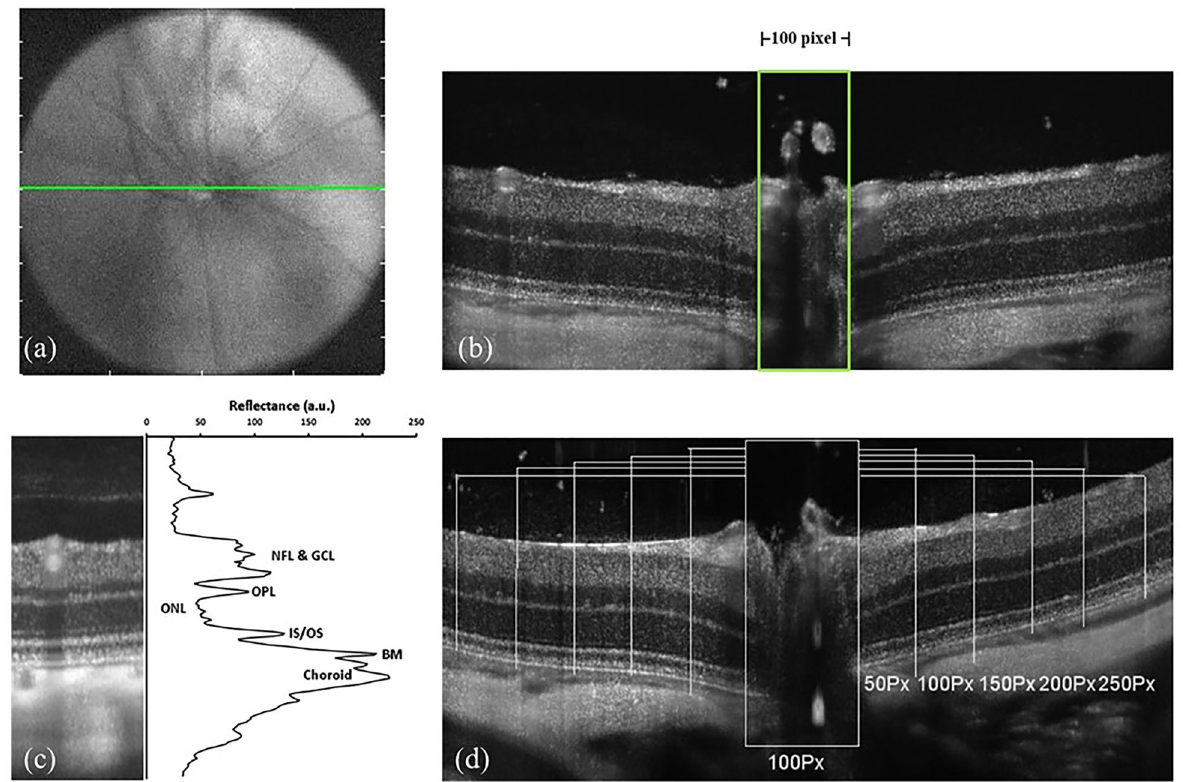
Figure 6. SD-OCT imaging protocol. ( a ) and ( b ) show the ONH landmark used for SD-OCT imaging. 100Px width used for measuring the ONL thickness. ( c ) shows the difference in the reflectivity of retinal layers from which the Longitudinal Reflectivity Profile (LRP) is generated. NFL, nerve fiber layer; GCL, ganglion cell layer; OPL, outer plexiform layer; ONL, outer nuclear layer; IS/OS, inner segment/outer segment junction; BM, Bruch’s membrane. ( d ) represents the LRP lines 50Px apart on either side of the